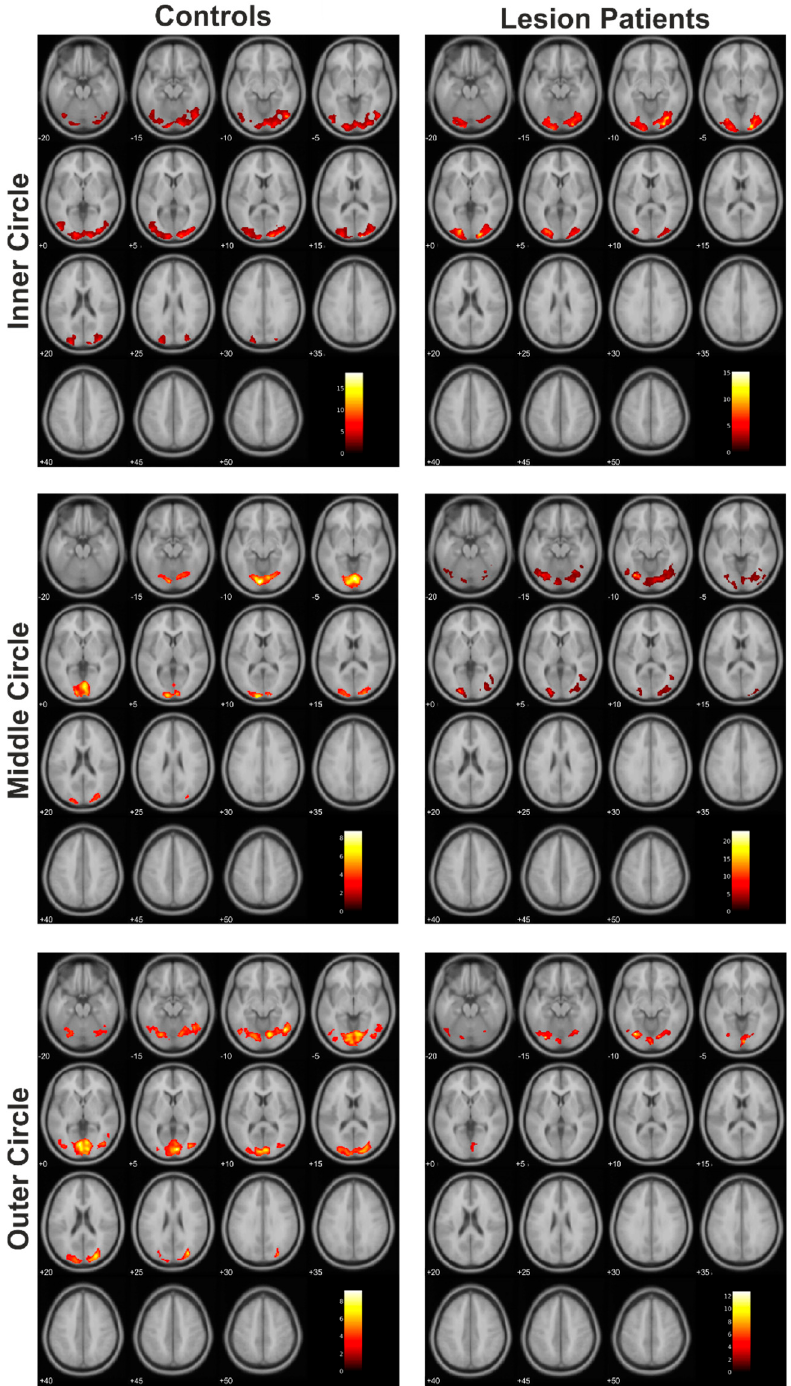
Figure 4. Cortical activation patterns within the control group and lesion patients group (each N = 7).